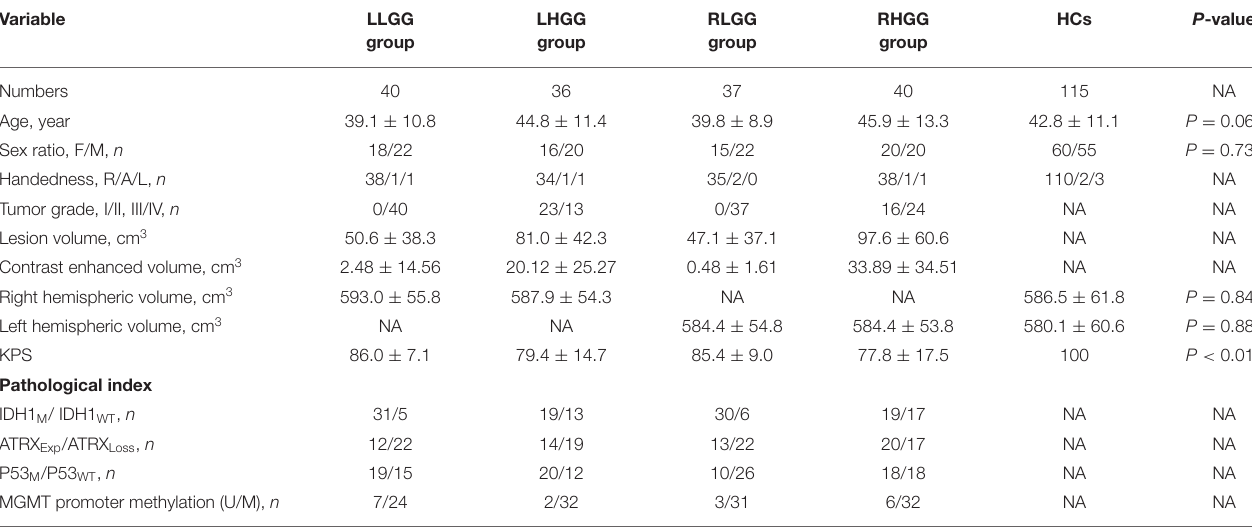
TABLE 1 | Demographic and clinical characteristics among four patient groups and healthy controls (HCs). Variable